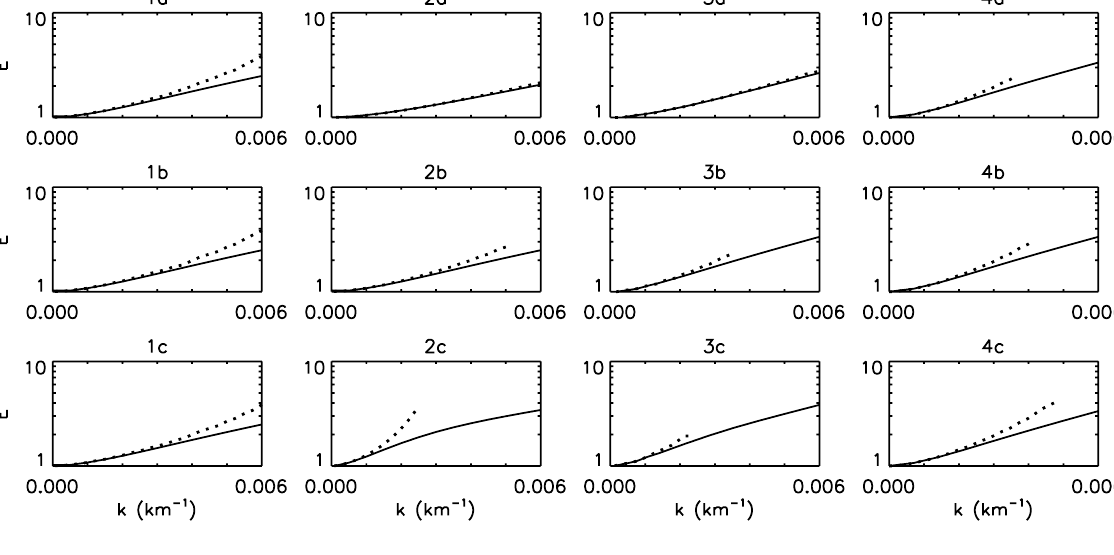
Fig. 10. Enhancement parameter in the maximum (dotted lines) and the minimum distortion directions (solid lines) for the twelve spectra presented in Figs. 6 to